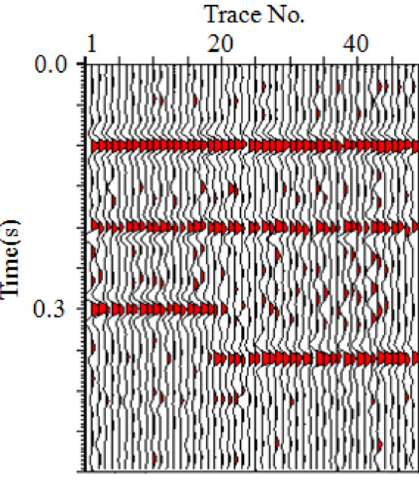
Fig. 3 Denoised result. The first three singular values in Fig. 2c, d are selected for reconstruction